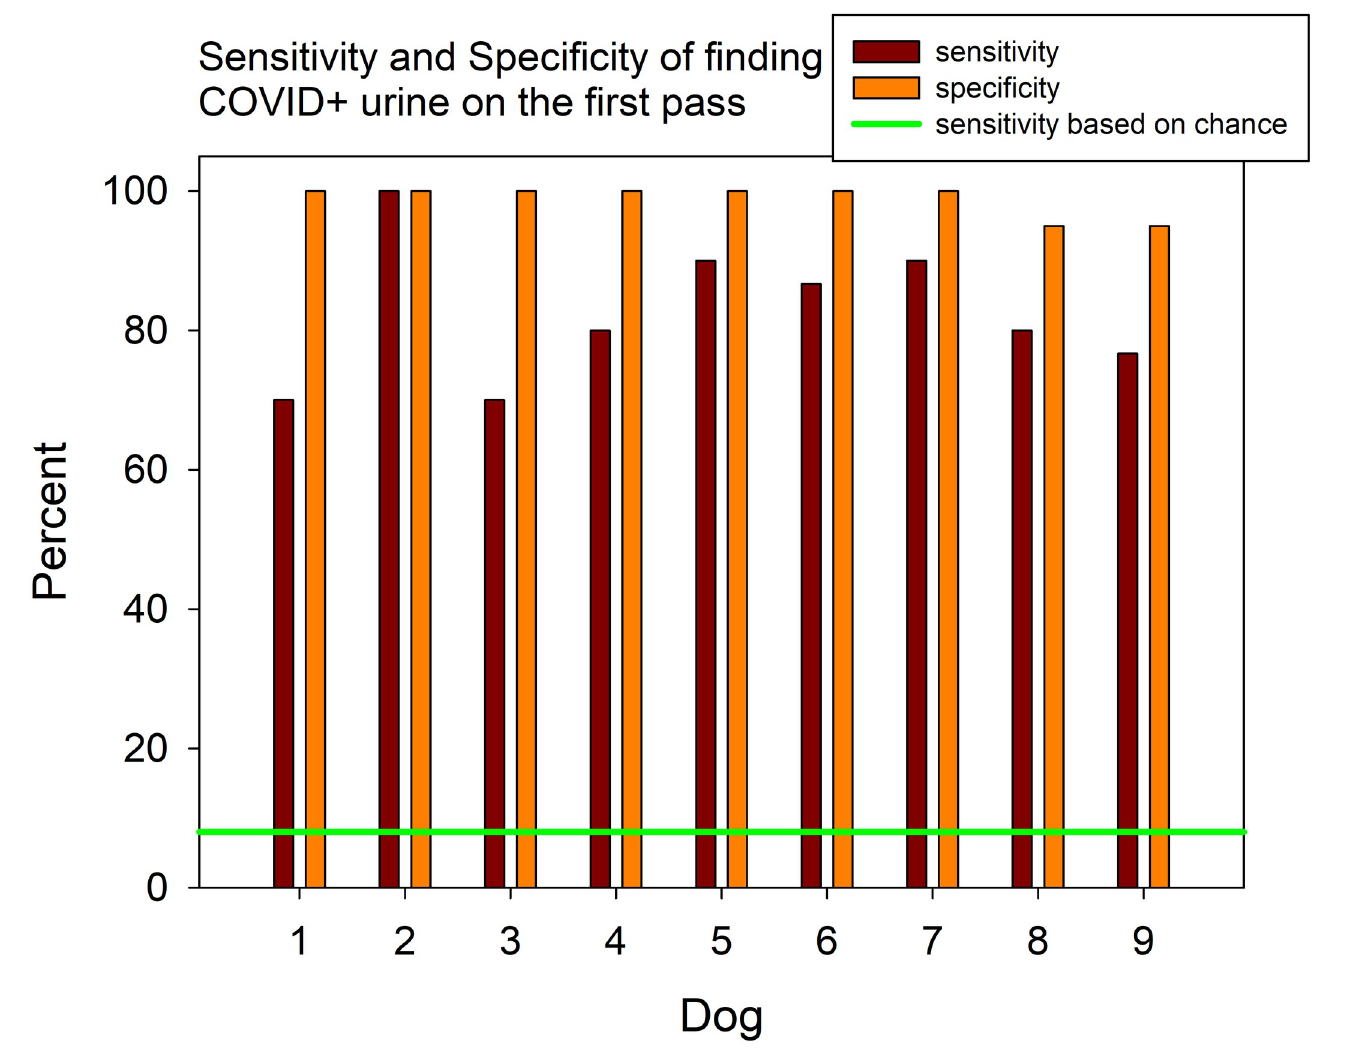
Fig 3. Sensitivity (dark red bars) and specificity (orange bars) of the individual dog’s response to novel mixes of familiar SARS-CoV-2 positive heat-treated urine samples on the first time they encountered the odor (first pass). The green line represents sensitivity based on chance.